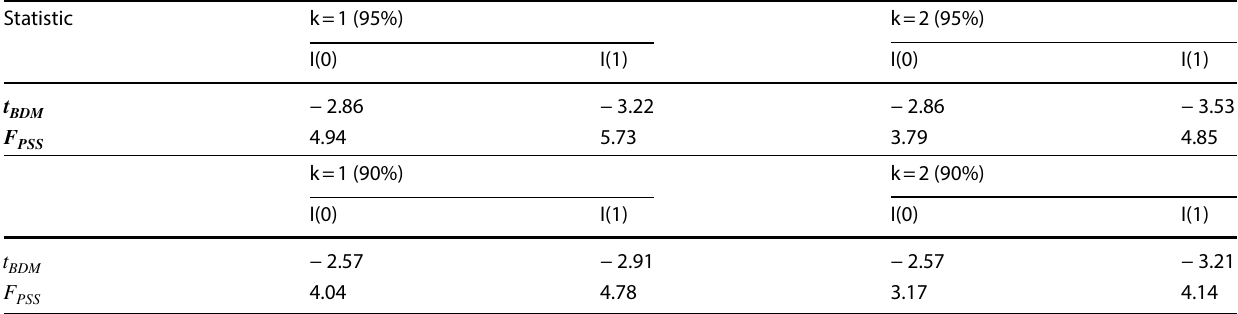
Table 2 Critical values of the cointegration tests